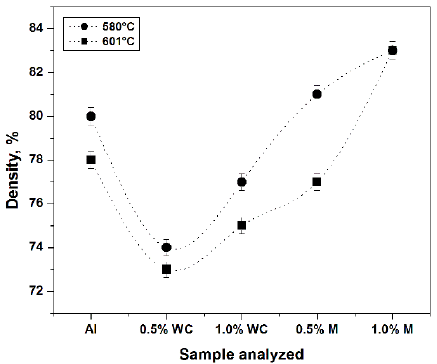
Figure 3. Results of the relative density reached by the samples with different compositions and sintered at different temperatures.